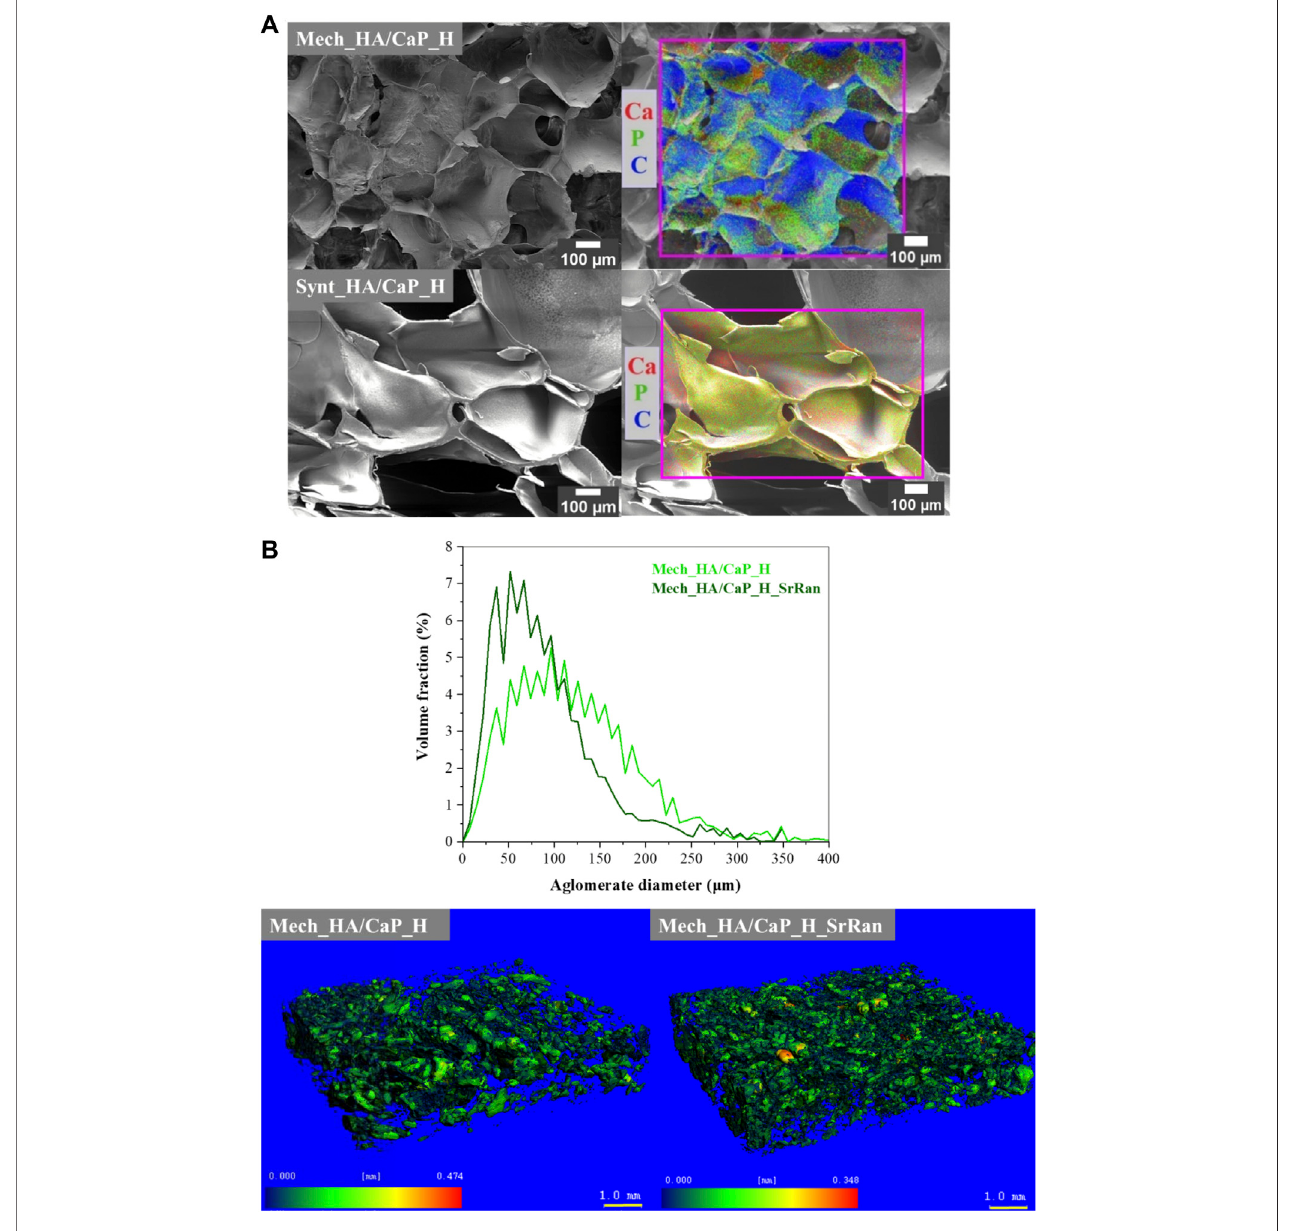
FIGURE 2 | CaP distribution within the HA matrix. (A) SEM-EDS microphotographs; (B) volume fraction as a function of agglomerate diameter of CaP agglomerates in the lyophilized hydrogels and heatmap of CaP agglomerates ’ size distribution in the hydrogel matrix.